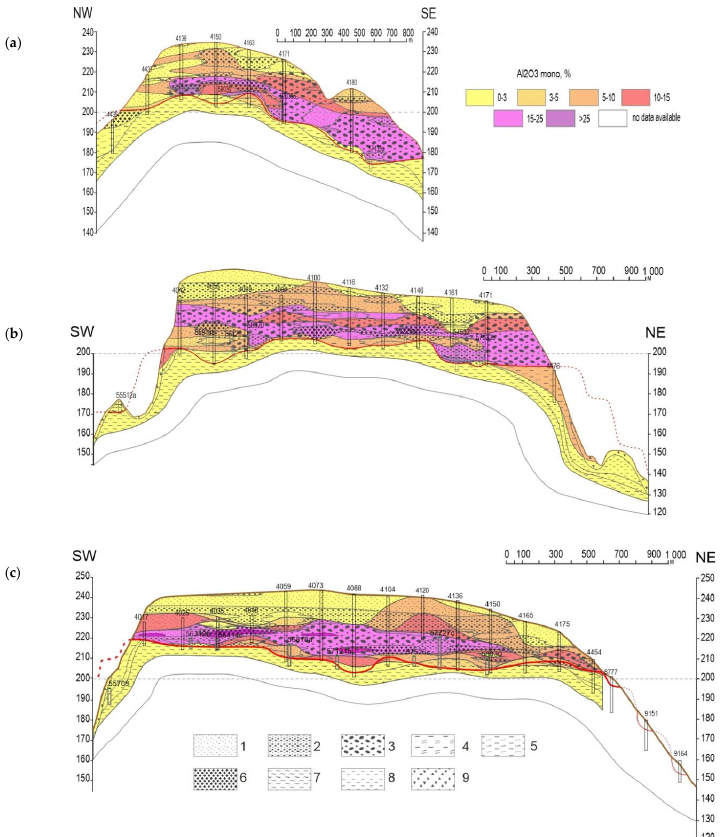
Figure 7. Distribution of aluminum monohydrate (Al 2 O 3 mono) at the Sangaredi bauxite deposit. Lithology: 1 — psammite sediments and bauxites; 2 — gravellite sediments and bauxites; 3 — con- glomerate sediments and bauxites; 4 — geliform bauxites; 5 — gelified bauxites; 6 — oolitic bauxites; 7 — clayey sediments and bauxites; 8 — classical bauxites and ferruginous laterites; 9 — deluvium. ( a ) the northeastern part of the deposit; ( b , c ) the central part of the deposit, the distance between the profiles is 300 m.